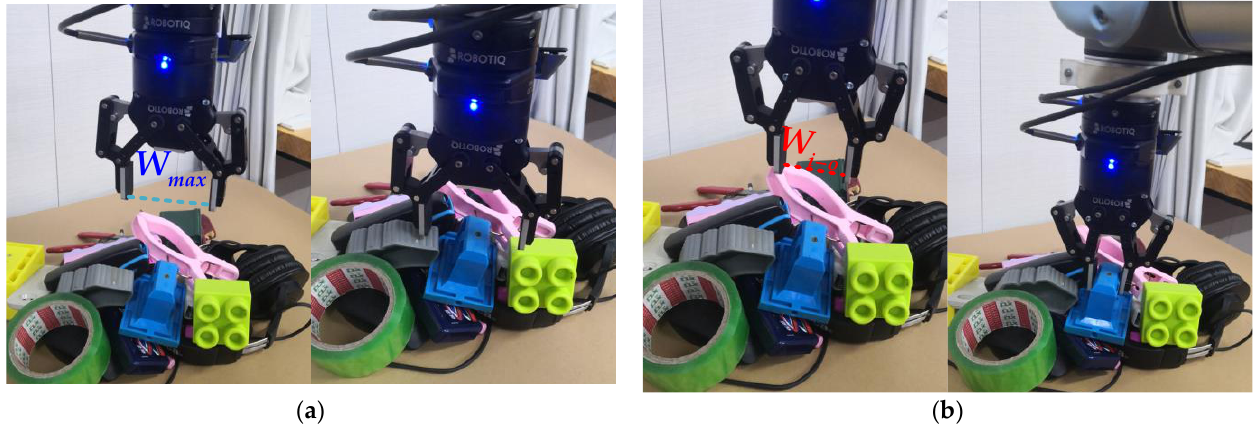
Figure 8. Robot open grasping results. ( a ) Robot failed grasping by the conventional method due to colliding with other objects; ( b ) robot successful grasping by our method with adaptive opening gripper configurations.